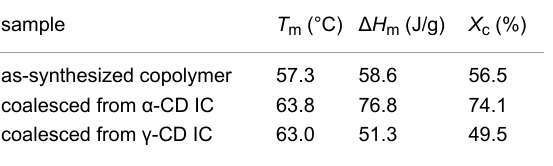
Table 2: Thermal properties and crystallinities of various PCL-PPG- PCL triblock copolymer samples, as revealed by DSC [21]. sample